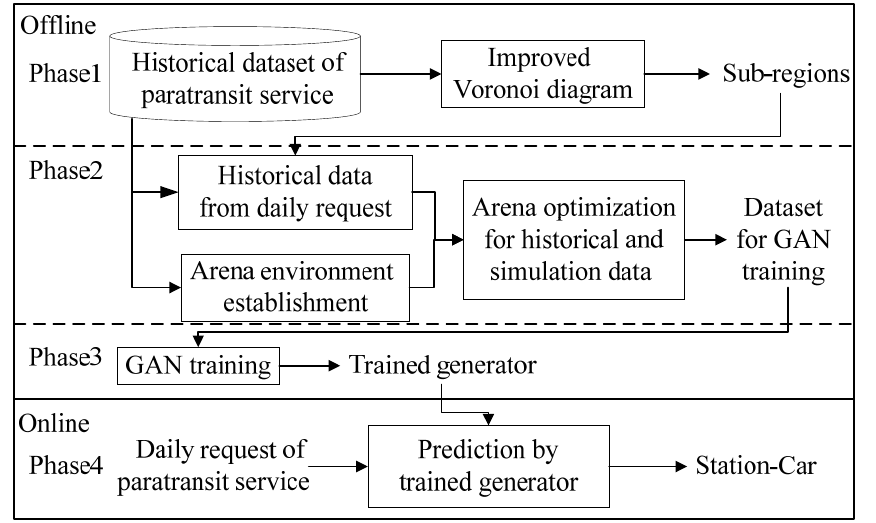
Figure 6. Proposed GAN-VAPS.